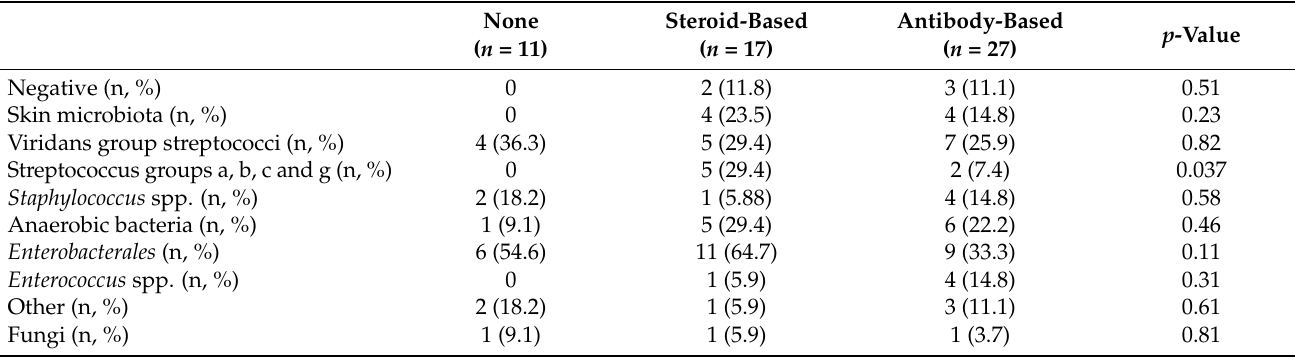
Table 3. Microbial spectrum and influence of immunosuppressive therapy.